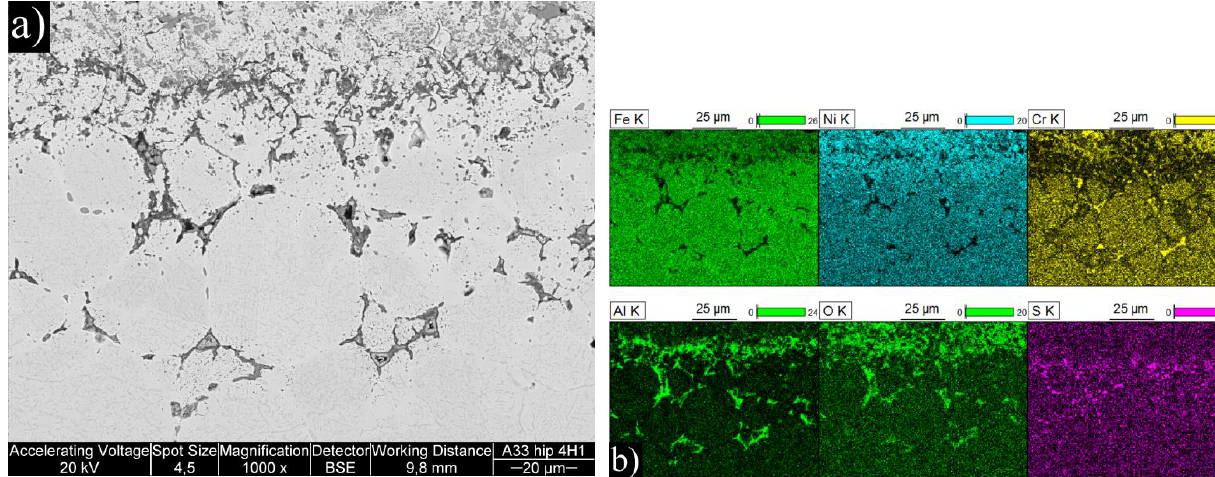
Figure 11. ( a ) SEM image of HIP (FeNiCrAl) cross-section near the surface after the exposure at 720 °C for 700 h; ( b ) EDX elemental map of the same